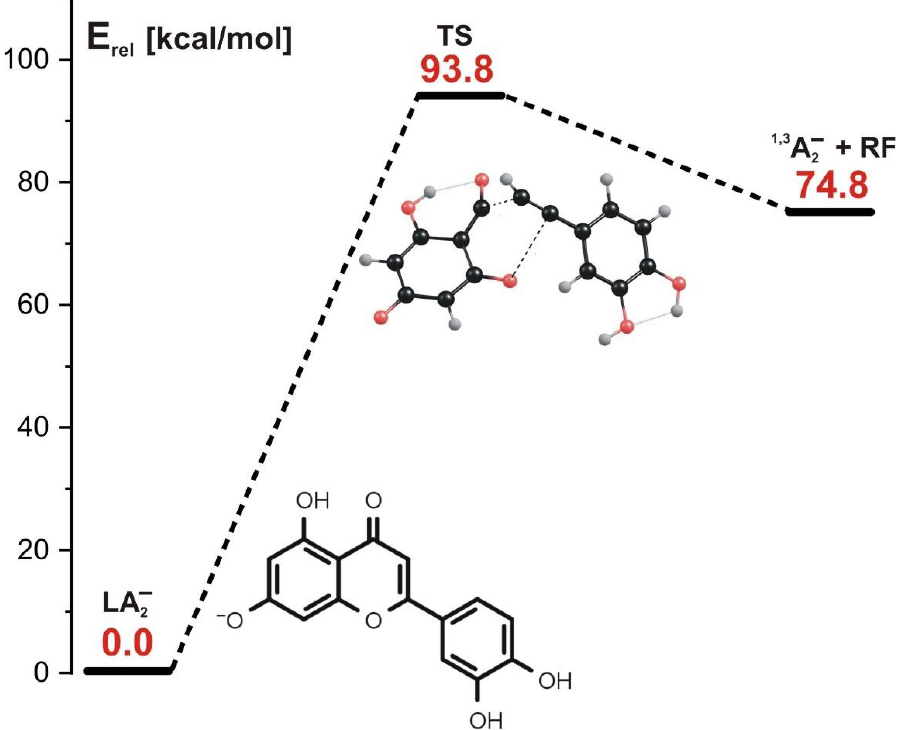
Figure 6. Energy profile for the 1,3-retrocyclization of LA 2- proceeding according to the concerted mechanism and resulting in the formation of 1,3 A 2- negatively charged product. The energies of the transition state (TS) and the separated products ( 1,3 A 2- anion and the remaining neutral fragment RF) are given (in kcal/mol) as the relative values (E rel ) with respect to the energy of the LA 2- substrate (taken as zero).